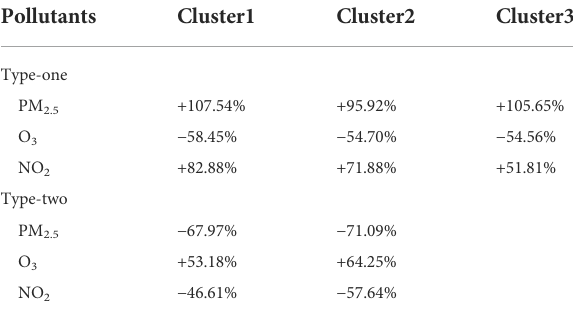
TABLE 2 Relative anomaly percent changes in PM 2.5 , O 3 and NO 2 concentrations in each backward trajectory cluster of the two seesaw events in Shanghai. Units: %. The relative anomalies are with respect to the average value of every hour in every